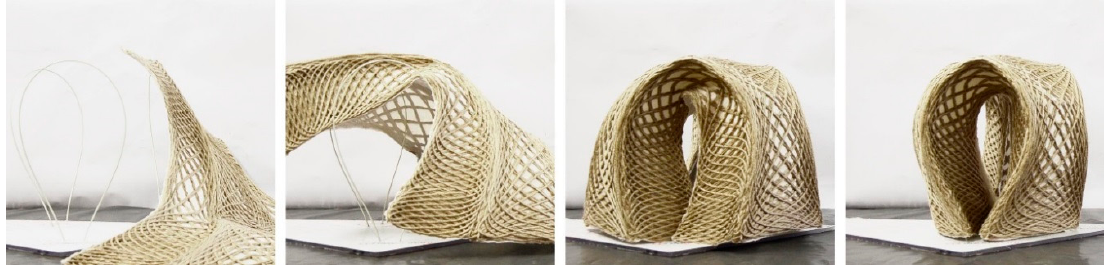
Figure 11. Process of placing a preform on bent scaffolding rods.